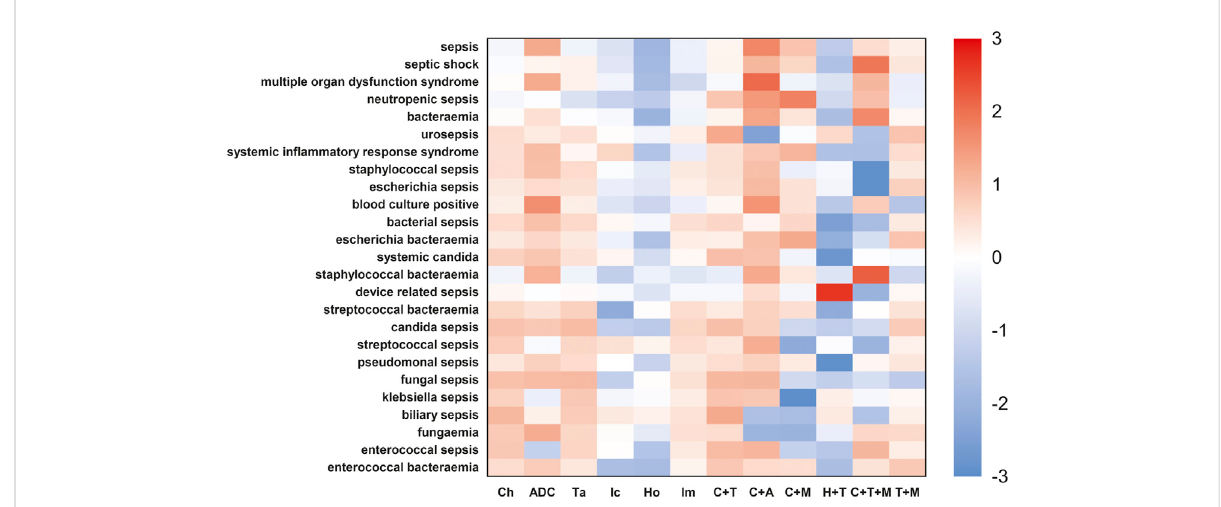
FIGURE 8 Sepsis-relatedtoxicitieslandscapeamongADCsandotheranticancertherapies(vs.in-classcontrol).In-classcontrolrepresentedothercancer patients not on a speci fi c drug class, for instance, the controls for the Ic group were cancer patients not on Ic therapy.Similarly, controls for Ta were cancer patients not taking any targeted therapy. The red color indicates a high risk of adverse effect in different cancer drug regimens. This analysis using another control group con fi rmed the fi ndings in Figure 7 that ADCs had the highest safety concern for sepsis, multiple organ dysfunction syndrome, pseudomonal sepsis, fungemia, and blood culture positive among any other cancer drug regimens ( p < 0.05).